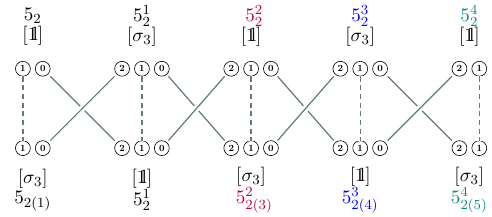
Figure 2 . T -duality chain of D(irichlet)-branes.